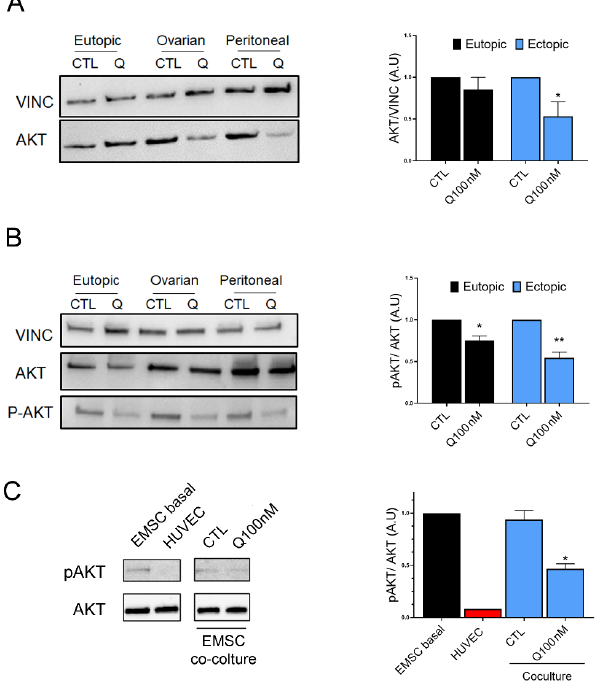
Figure 6. Quinagolide effect on AKT activation. ( A ): Representative western blot analysis and quantification of AKT levels in eutopic and ectopic E-MSCs treated for 48 h with 100 nM quinagolide (Q), compared to untreated cells (CTL). ( B ): Representative western blot analysis and quantification of P-AKT levels, normalized to AKT expression, in eutopic and ectopic E-MSCs treated for 48 h with 100 nM quinagolide (Q), with respect to untreated cells (CTL). ( C ): Representative western blot analysis and quantification of P-AKT levels in HUVECs, ectopic E-MSCs (E-MSC basal) and in E-MSCs after co-culture with HUVECs, treated or not for 24 h with 100 nM quinagolide (Q100 nM). Data are represented as mean ± SD of at least two independent experiments, performed on different E-MSC lines, and normalized to Vinculin and to untreated cells (CTL). One-way ANOVA was performed: * = p < 0.05 and ** = p < 0.001 vs. CTL.